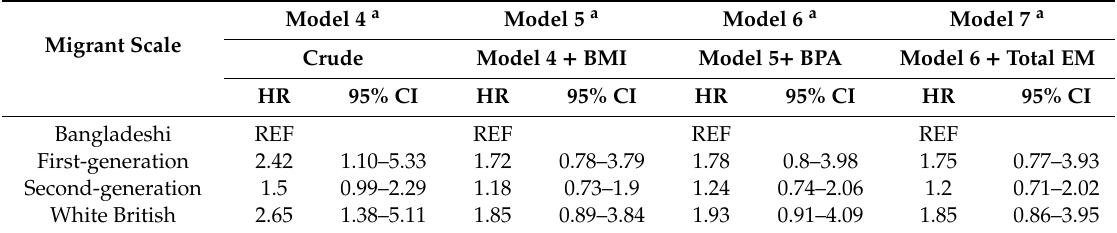
Table 5. E ff ect of BPA on the association between migrant scale and risk of thelarche among British and Bangladeshi girls 5–16 years of age, ABBY Project, includes sample with BPA assay ( n =